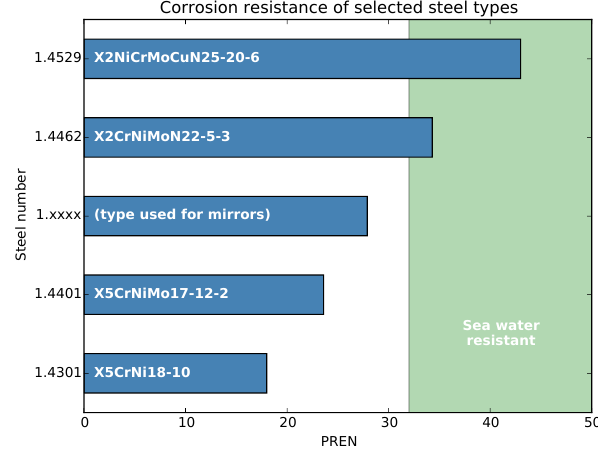
Figure 6. PREN for common stainless steel types. Steel numbers and grades are according to the European EN 10088-3 norm (Euro- pean Committee for Standardization, CEN). The steel type labelled as 1.xxxx is the one that was chosen for the